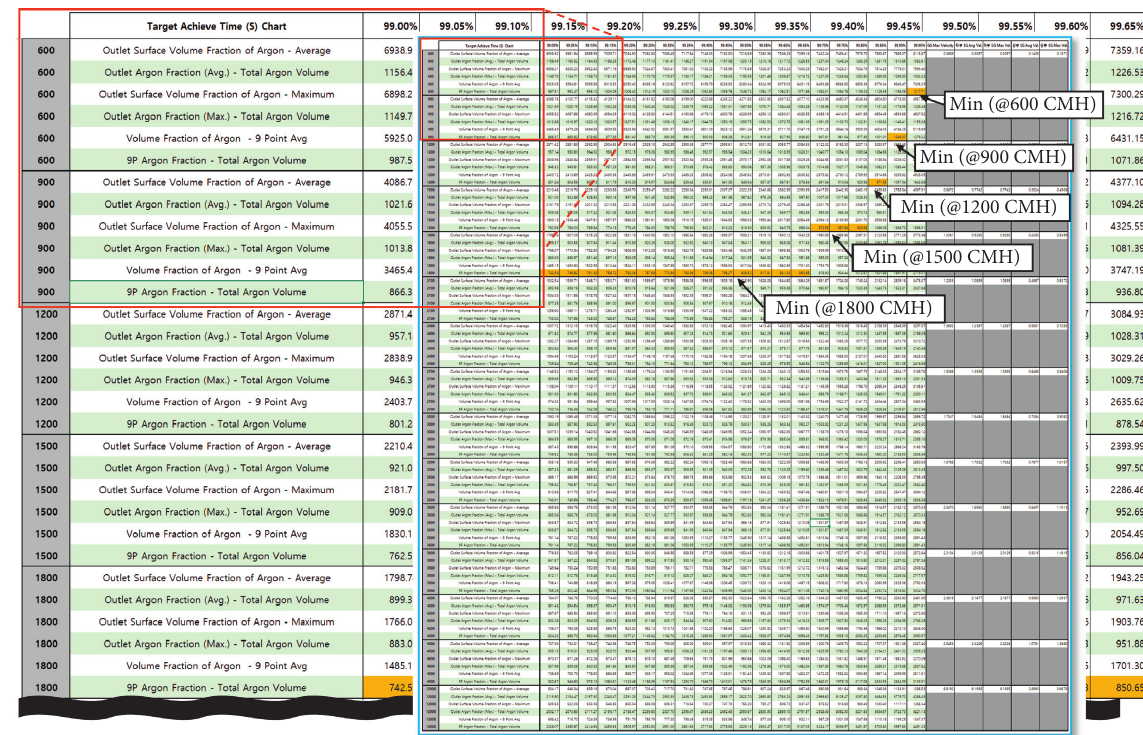
Figure 13: Simulation results of the total volume to achieve the nine-point argon fraction for the entire range of flow rates considered in this study (from 600 to 12,000 CMH) and selected range of flow rates for a